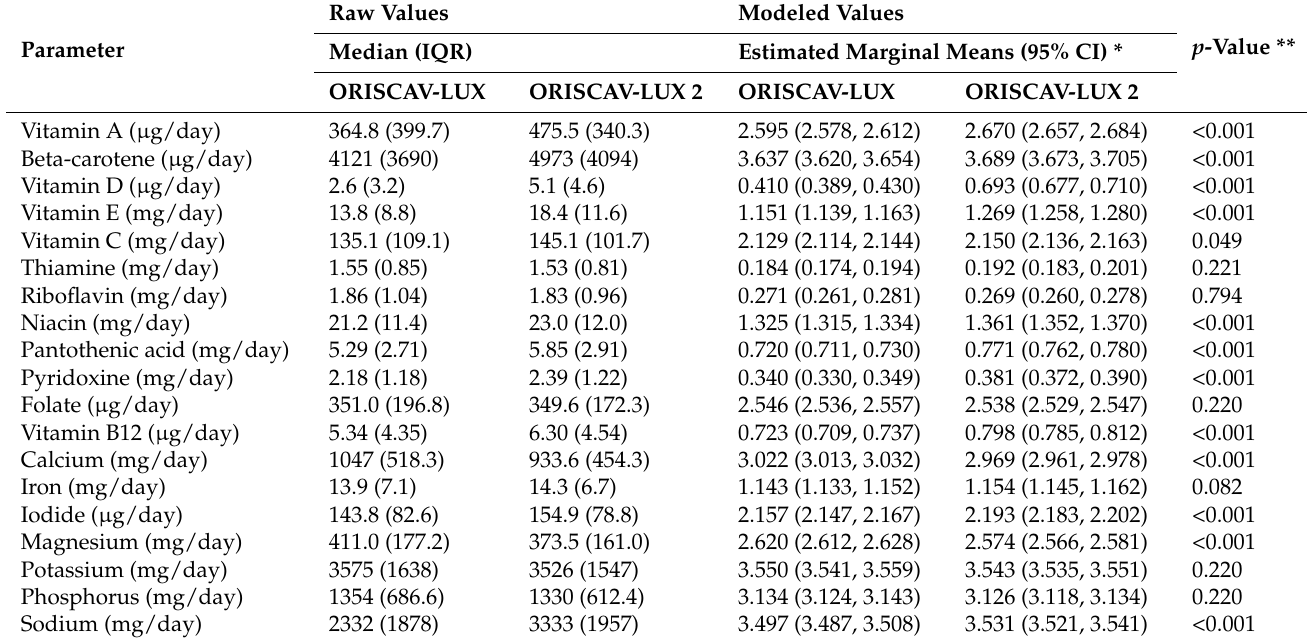
Table 3. Median (interquartile range) and estimated marginal means of micronutrient intake of participants ( p -values are based on linear mixed models, as explained in footnotes).